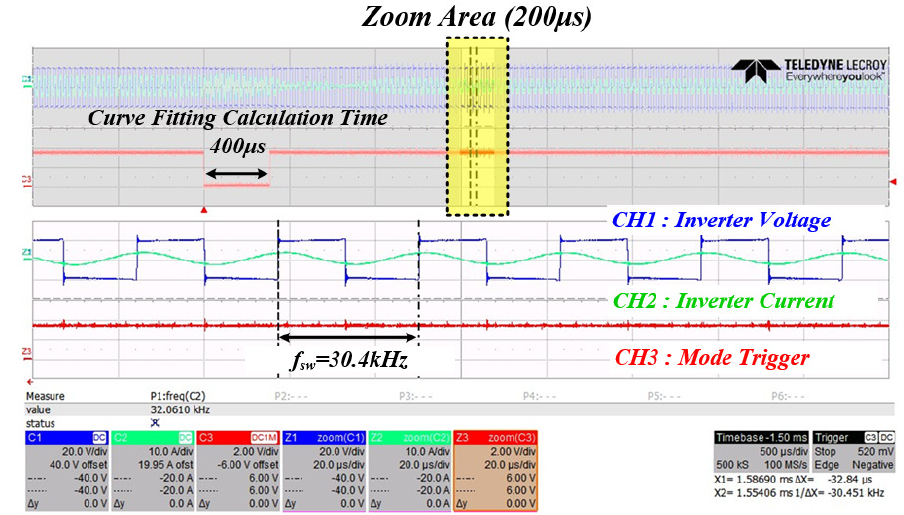
Figure 24. Inverter output waveform when in mode